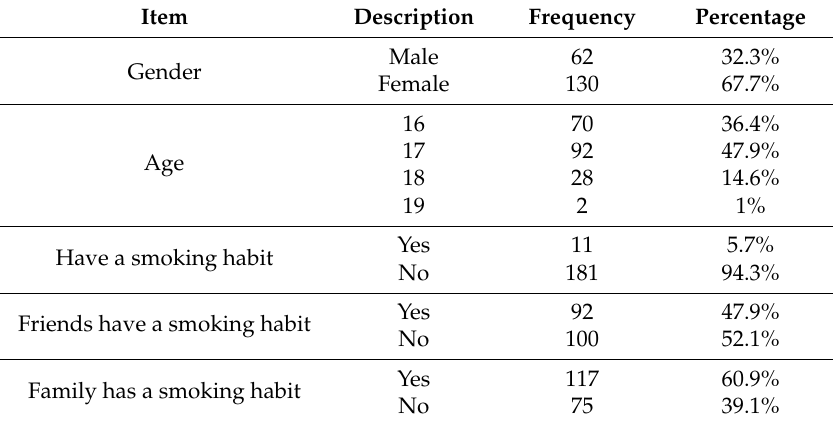
Table 1. Description of respondents in Study